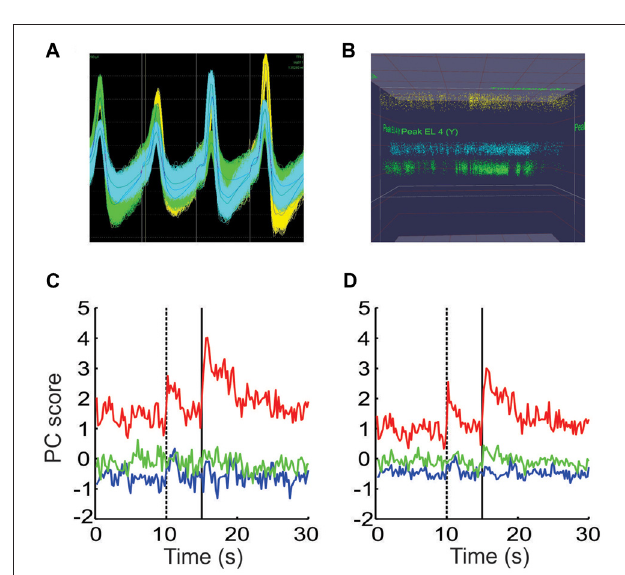
FIGURE 8 | Controlling for other potential causes of the shifts in ensemble dynamics. (A) The waveforms of all spikes from three putative neurons recorded from a single tetrode. (B) A plot of the peak height of all spikes recorded on two wires throughout the session, using the same colors as in (A) . The peak height of the waveforms remained stable while the density of points fluctuated throughout the session. (C) PCA performed on the spike count data from a single session using the raw spike counts. (D) PCA performed on a matrix composed of the remaining portion of each neuron’s spike counts that were not accounted for by the animal’s movements. sessions, the ensembles shifted from representing the prior outcome to the current outcome at the start of each new trial and the shift was larger if the current outcome was